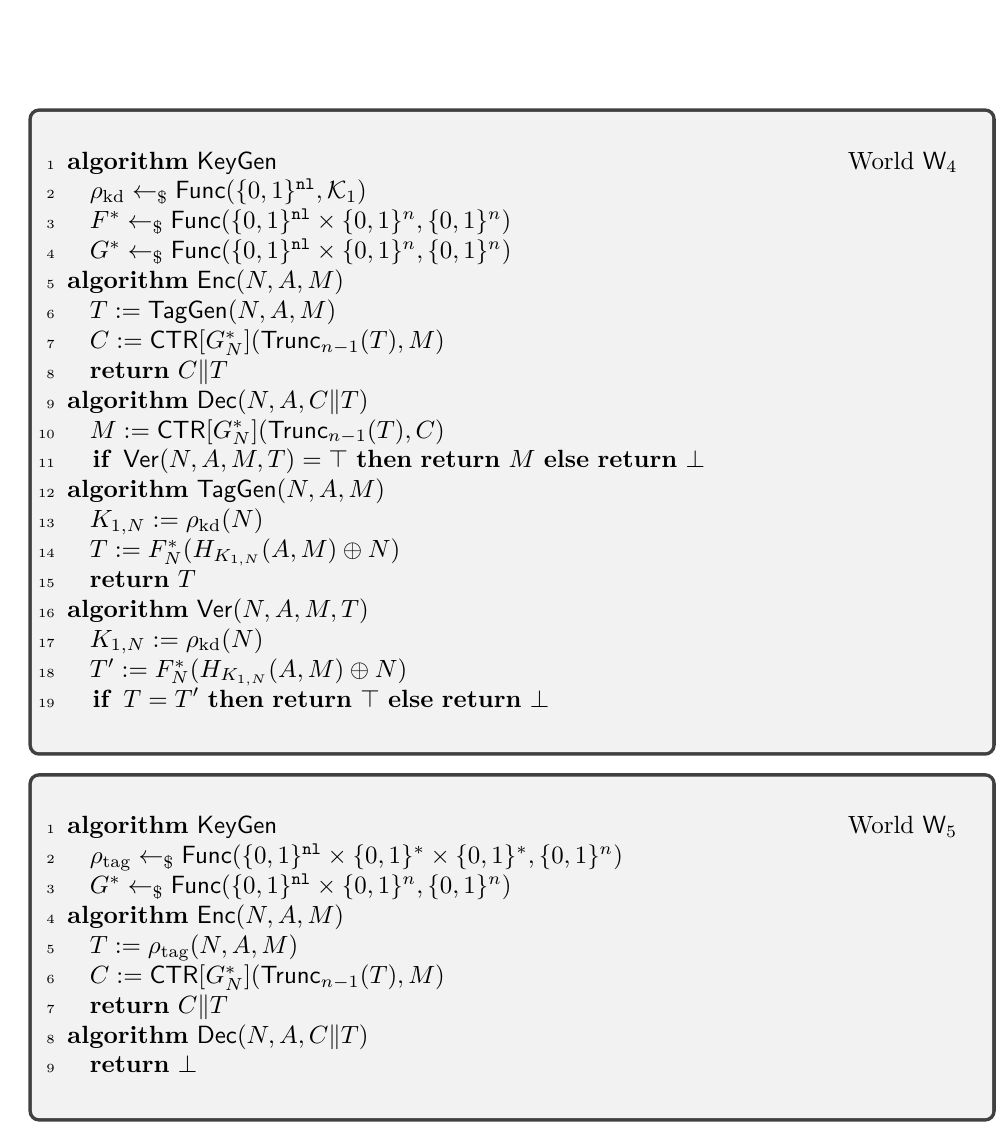
Figure 3: Worlds W 4 - W 5 used in the proof of Theorem 3. The keyed hash function H is defined as in Equation